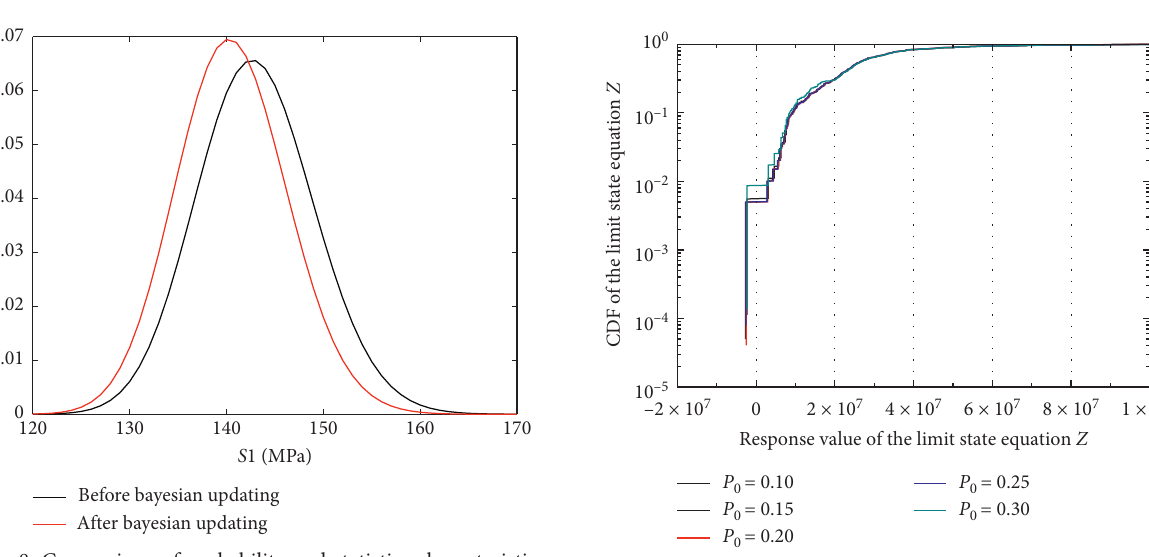
Figure 9: CDF of survival rate at 95%.